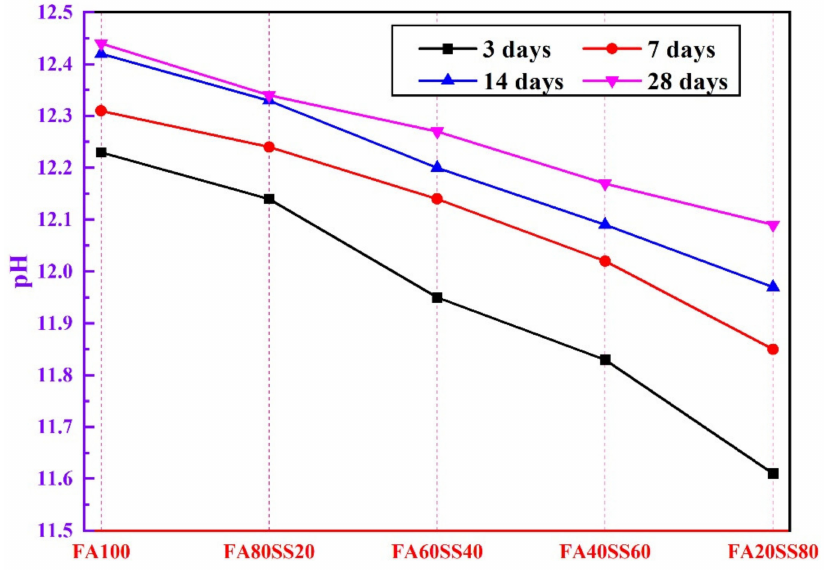
Figure 7. The pH values of leaching solutions of